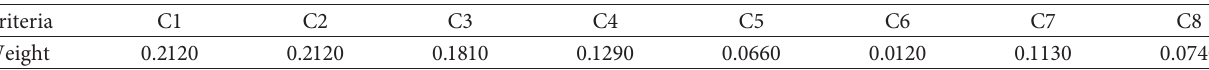
Table 9: Criteria